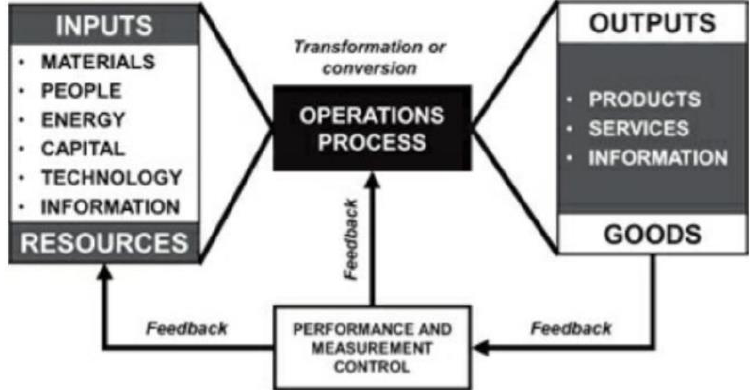
Figure 1: Operating System (source: De Toni,